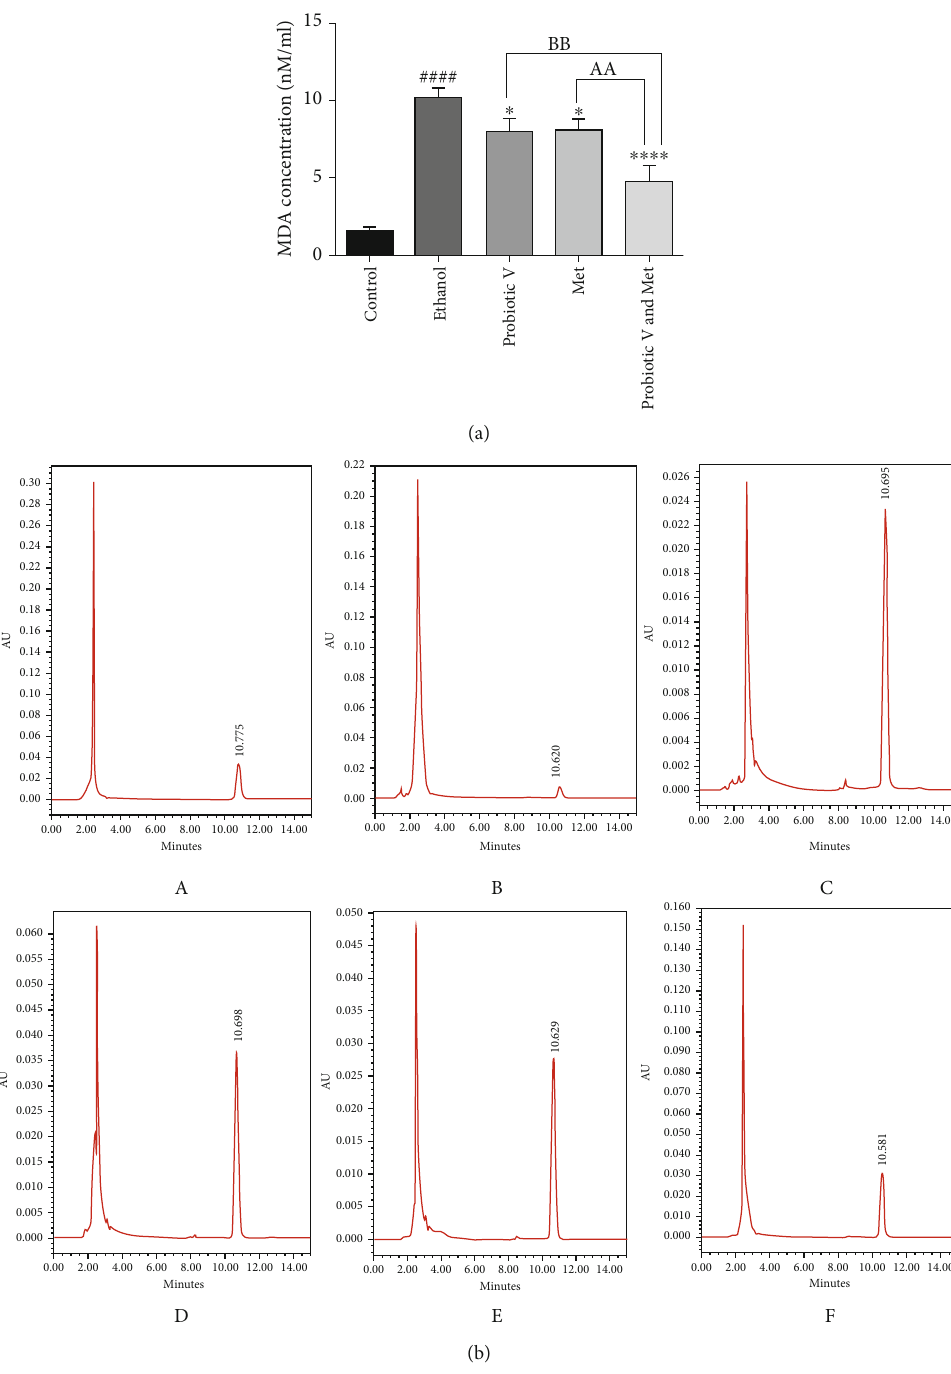
Figure 4: (a) MDA estimation in HepG2 cells by HPLC method. Here, 100 mM ethanol-exposed HepG2 cells were treated with 100 μ l/ml probiotic V and 1 mM Met alone or together as probiotic V and Met combination for 48 h. The amount of MDA was quanti fi ed with reference to the standard area under the curve (AUC), and values represent the mean ± SD of three individual experiments. Statistical signi fi cance was assessed by one-way ANOVA followed by Tukey post hoc test. Statistical analysis: #### p < 0 : 0001 compared with control group; ∗ p < 0 : 05 and ∗∗∗∗ p < 0 : 0001 compared with ethanol group; AA,BB p < 0 : 01 compared with probiotic V and Met combinatorial group; (b) HPLC chromatograms of cells MDA after DNPH derivatization are shown as follows (A) MDA standard, (B) control, (C) 100mM ethanol, (D) 100 mM ethanol+1 mM Met, (E) 100 mM ethanol+10 μ l/ml probiotic V, and (F) 100mM ethanol+10 μ l/ml probiotic V and 1mM Met combination. HepG2 cells were treated with ethanol alone or along with probiotic V and Met alone or together as probiotic V and Met combination for 48h. After 48 h of incubation, hydrolyzed cells were mixed with DNPH and analyzed by HPLC using the ODS2 reverse-phase column. Acetonitrile and autoclaved milli-Q water containing 0.2% acetic acid in the ratio 38: 62, respectively, was used as mobile